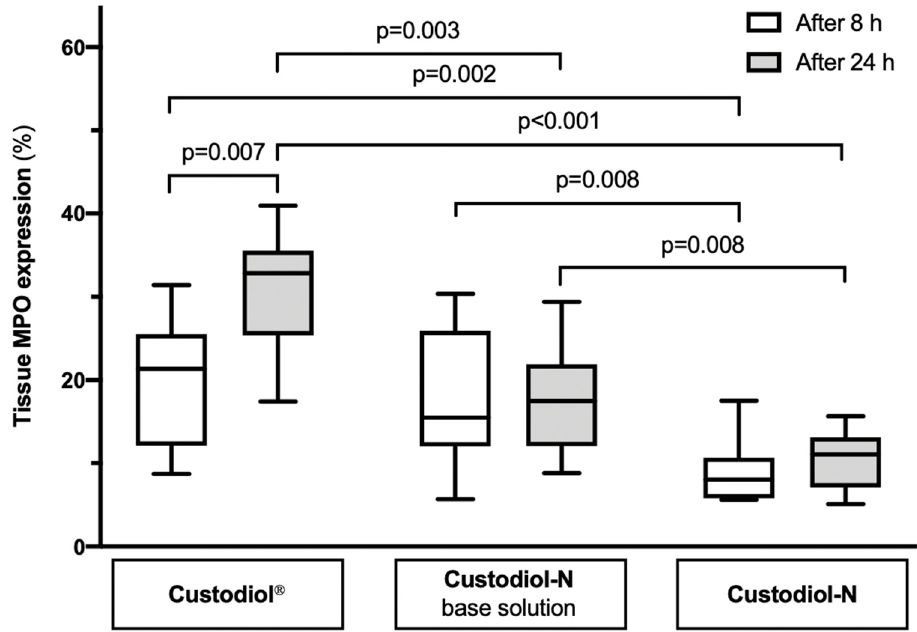
Figure 2. The percentage of myeloperoxidase (MPO) expression in uterus tissue cells preserved in di ff erent solutions for 8 and 24 h.